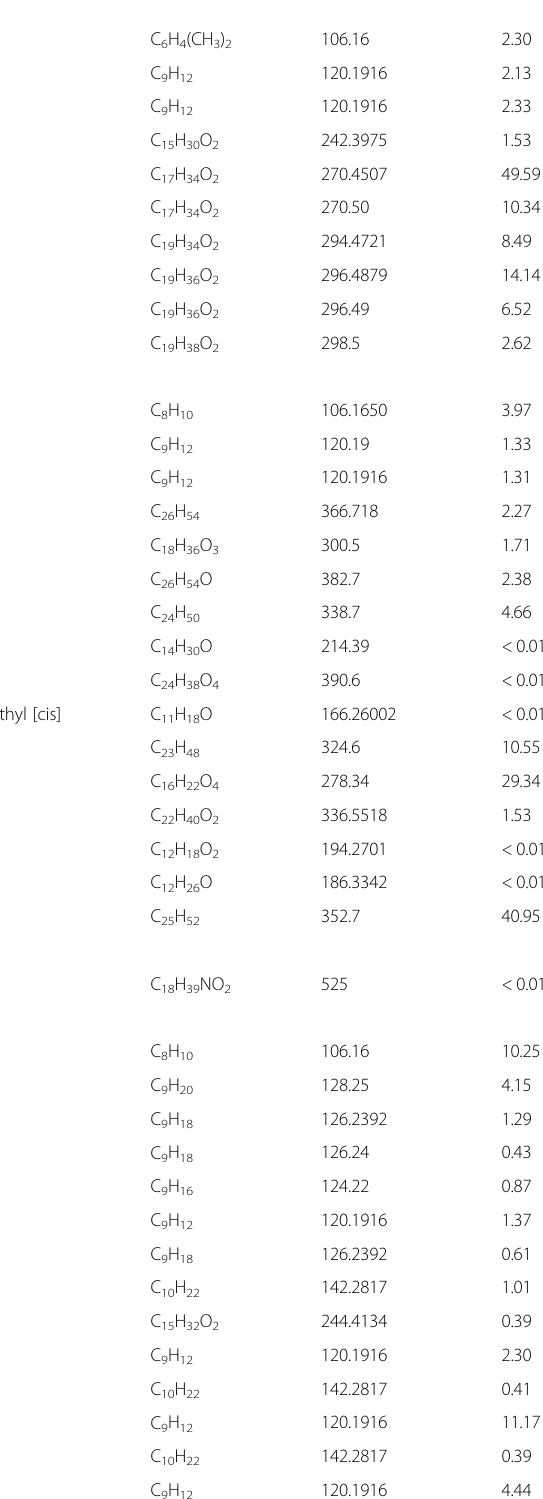
Table 2 Phytocomponents of (A) petroleum ether extract of A . occidentale , (B) ethylacetate extract of A . occidentale , (C) n -hexane extract of P . guajava , (D) petroleum ether extract of T . catappa , (E) ethylacetate extract of T . catappa